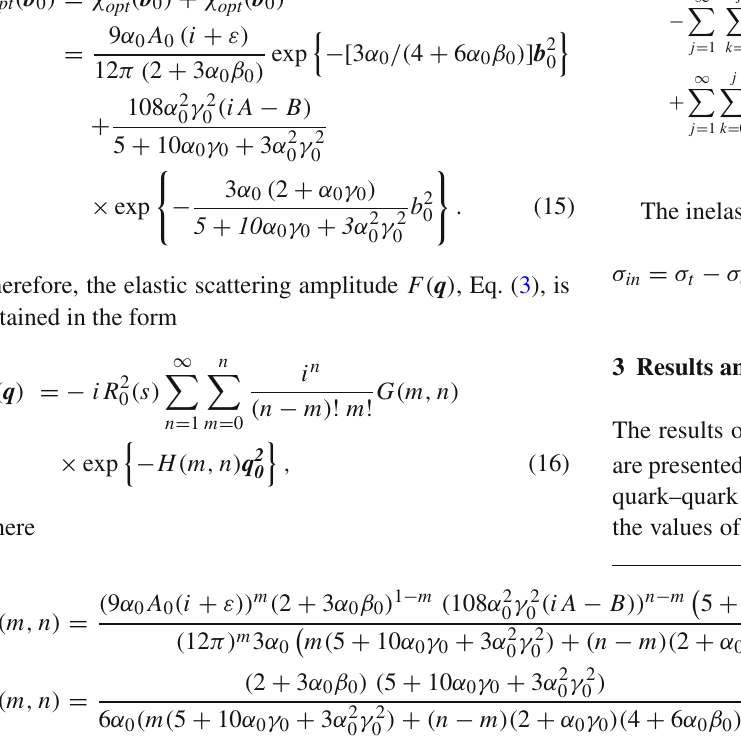
Table 1. In these calculations, the value of root mean square (cid:14) (cid:15) 1 / 2 = 0 . 868 fm, noting that the exper- r 2 radius of proton is p imental value of proton radius is r p = 0 . 84 − 0 . 87 fm [35]. The data at 7, 8 and 13 TeV is taken from the Refs. [1,4,6–8], respectively. A complete set of 7 TeV data with statistical and systematic errors is given in [1] for q 2 up to 2 . 44 ( GeV / c ) 2 , while the data at 8 and 13 TeV are preliminary and the statis- tical and systematic errors are given only up to 0 . 2 ( GeV / c ) 2 . Therefore, to show the extent of agreement of the calculations (cid:23) n ( (d σ / dq 2 ) with the data the quantities χ 2 / N DF = [ exp . i = 1 i − (d σ / dq 2 ) ) 2 / error 2 ] / n, [ (d σ / dq 2 ) − (d σ / dq 2 ) ] / (cid:12) theo . exp . theo . i i i i + error 2 ) − (d σ / dq 2 ) ] / error 2 and [ (d σ / dq 2 exp . theo . stat . syst . i i ) (d σ / dq 2 theo . are calculated for 7 TeV as in the Ref. i